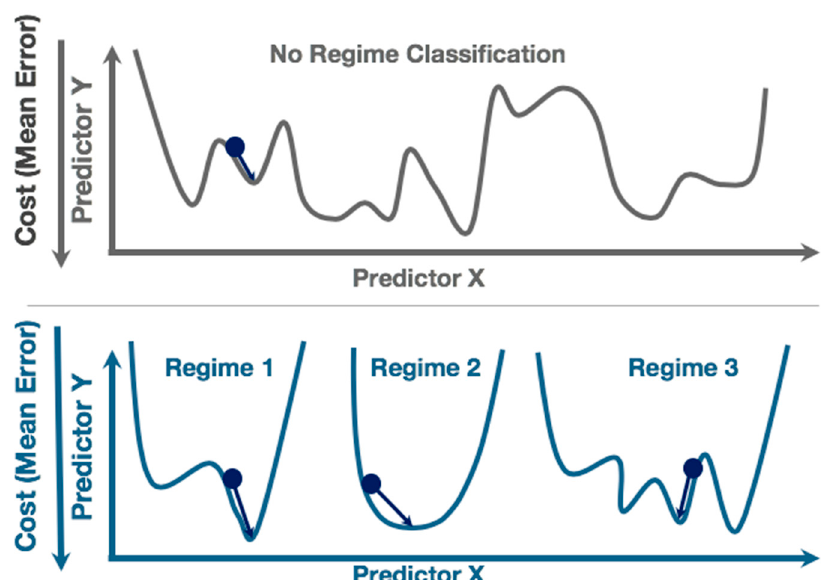
Figure 1. Illustration of how an Artificial Neural Network (ANN) training with no regime classification may have difficulty finding the global minimum in the cost function compared to a regime-dependent (RD)-approach that can find more global minima in the cost functions.